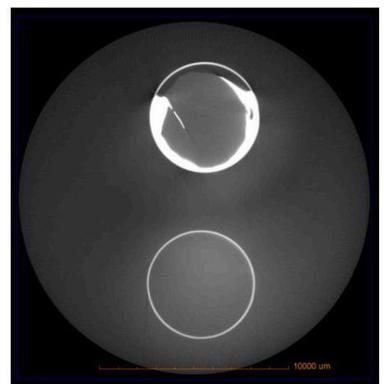
Micro-CT images showing contact area (light-grey area) between material sample and bottom of aluminum pan: (left) TPU sample only and (right) TPU sample mounted on HTA, with light areas indicating HTA.